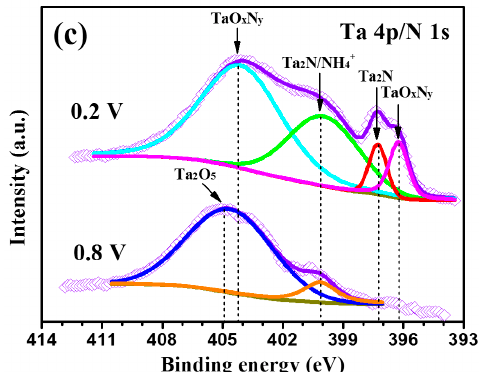
Figure 12. ( a ) XPS survey spectra and ( b , c ) high-resolution XPS spectra for Ta 4f and Ta 4p/N 1s for the passive films formed on the Ta 2 N coating after potentiostatic polarization at 0.2 V and 0.8 V for 60 min in Ringer’s physiological solution.